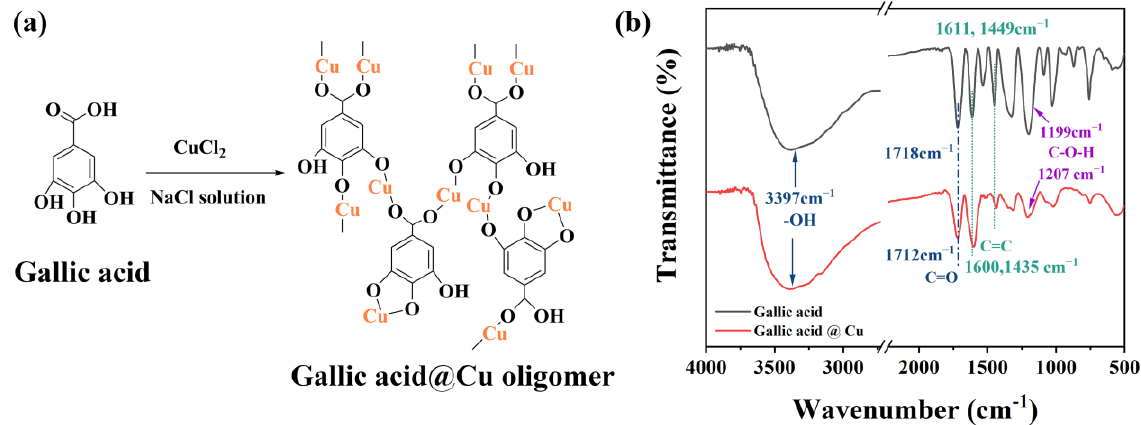
Figure 2. ( a ) Illustration of chemical structure, ( b ) FT-IR spectrum of gallic acid and after complex with Cu(II).